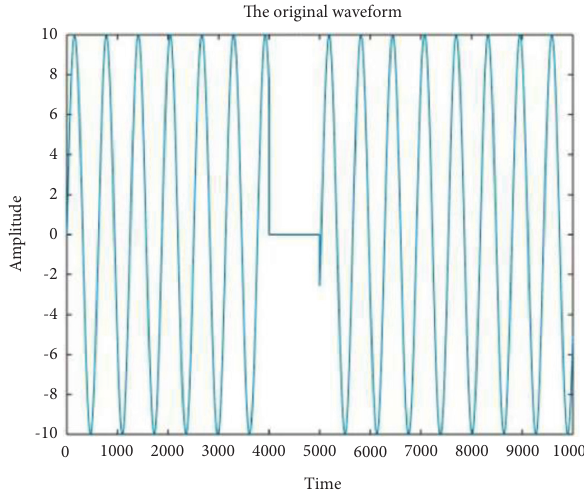
Figure 4: Waveform of the sample